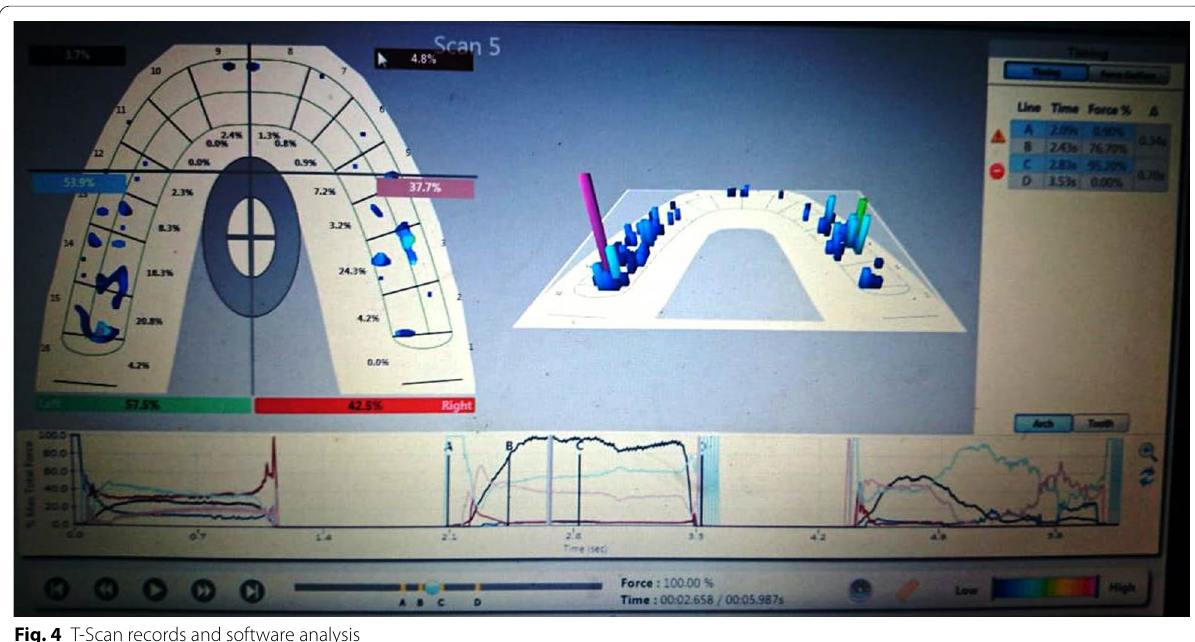
Table 1 Percentages of Occlusal forces before and after denture relining in anterior, right posterior and left posterior areas